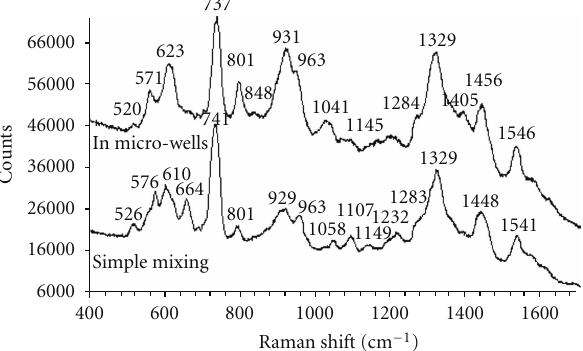
Figure 5: Comparison of SERS spectra of E. coli obtained in microwells and with simple